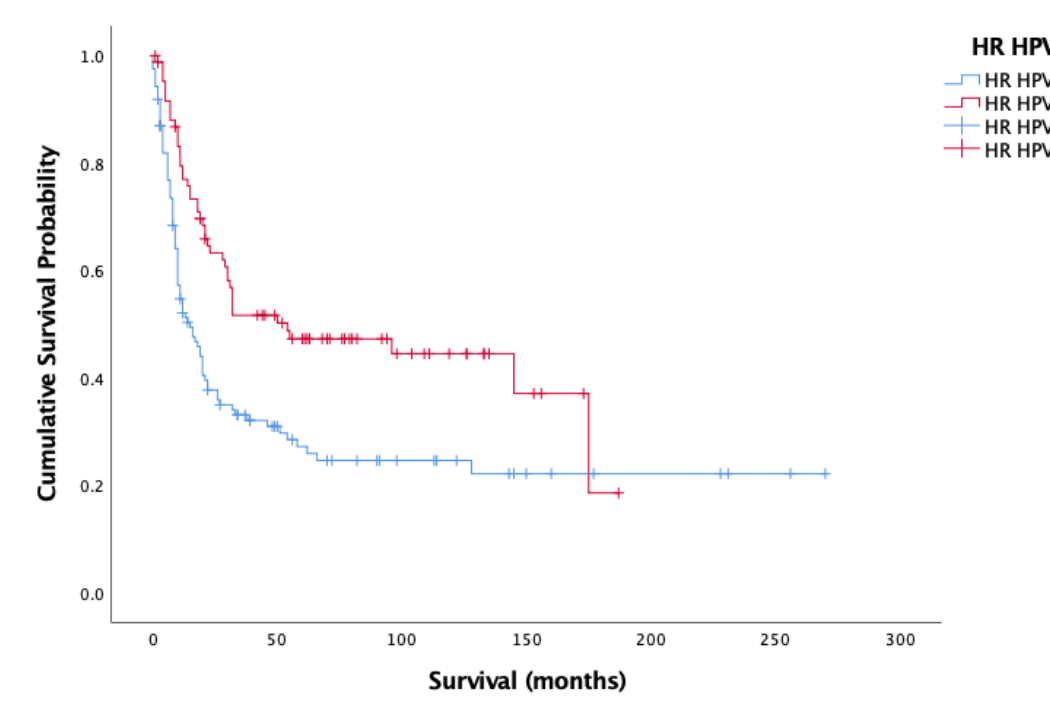
Figure 4. Kaplan – Meier analysis of disease-specific (cancer-specific) survival in months based on HR HPV status for oropharyngeal cancer (n = 209).